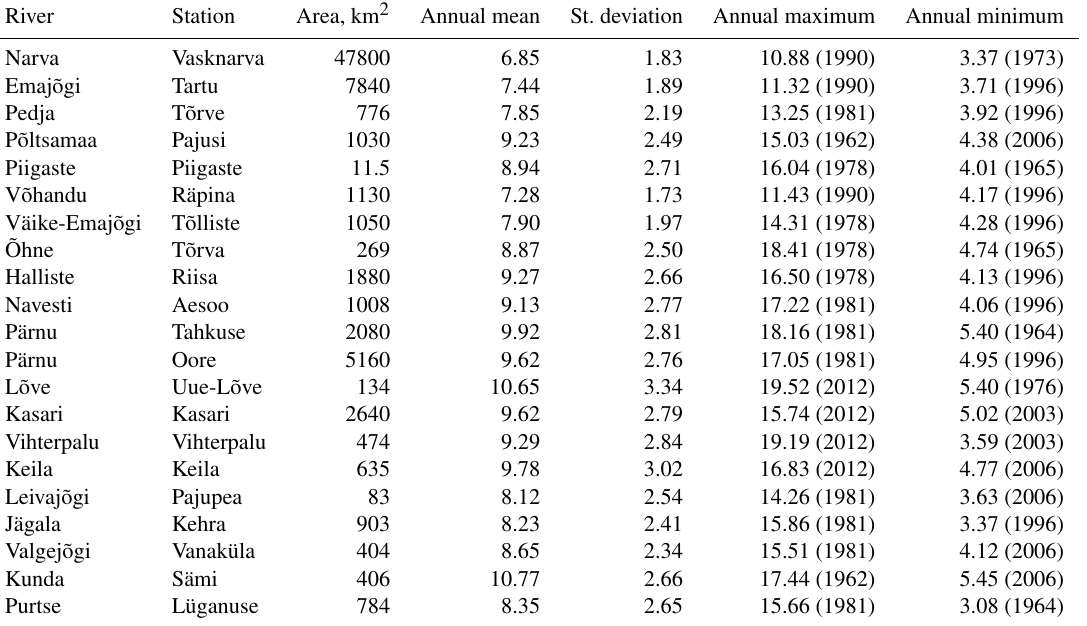
Table 1. The list of hydrological stations used in this study, their catchment areas and characteristics of annual mean specific runoff (Ls − 1 km − 2